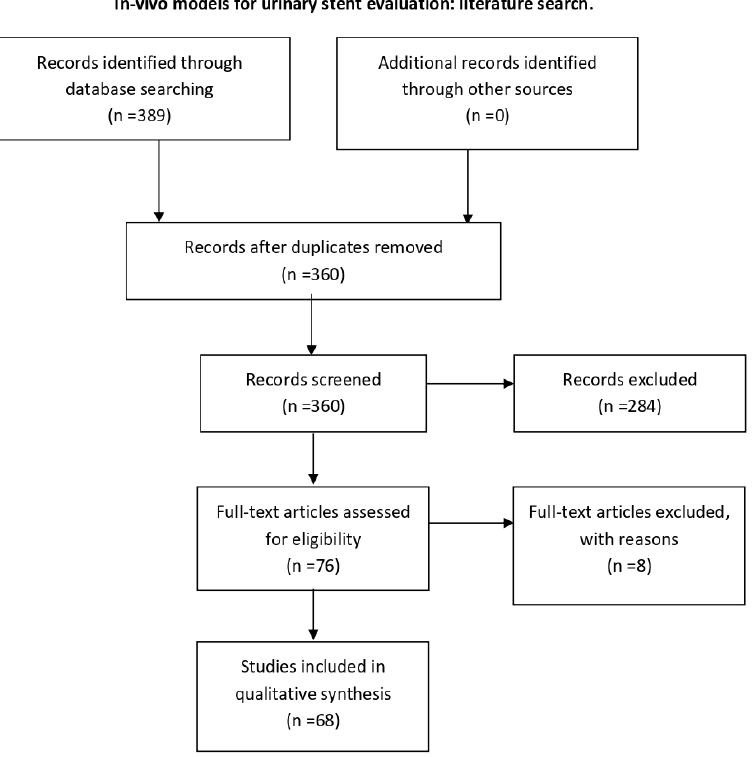
Figure A3. PRISMA flow algorithm; search of databases: PubMed, Scopus, Web of Science. Keywords: validation; testing; urinary stent; ureteral stent; urethral stent; animal model; in vivo; time period until 2021. Exclusion criteria: non-relevant, not in vivo, non-English, no abstract available,